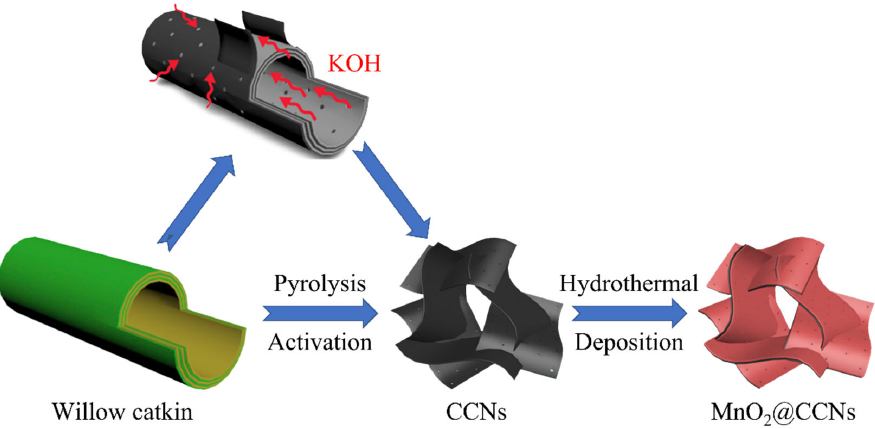
Figure 7. Preparation scheme of manganese oxide loaded carbon nano ‐ sheets by KOH activation supercapacitors. Reprinted with permission from Ref. [138]. Copyright © 2015 Elsevier